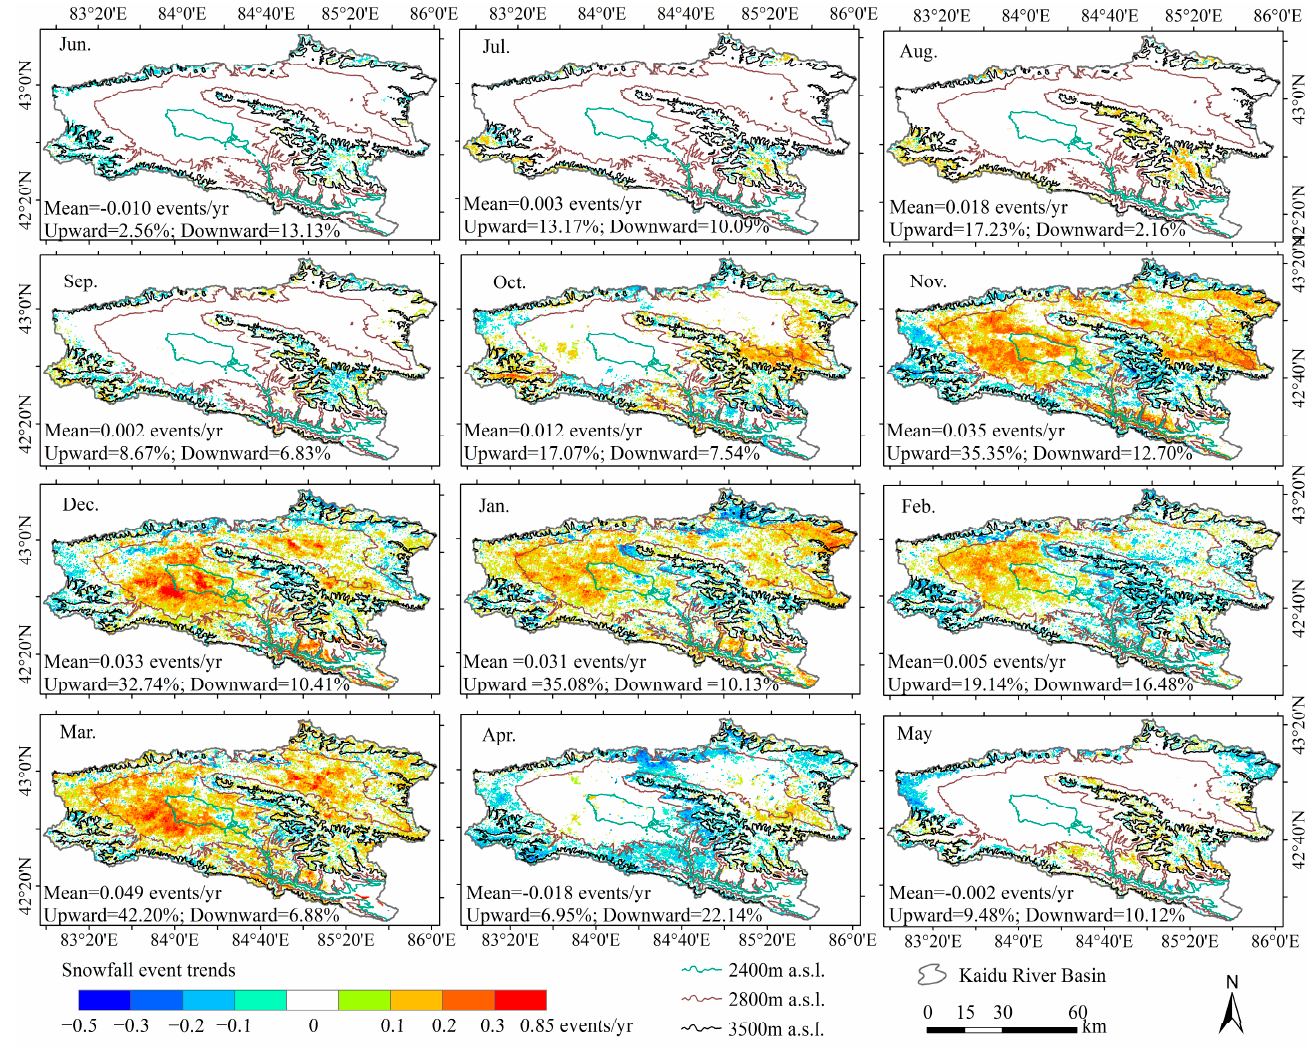
Figure 14. Spatial distributions of the trends in the monthly snowfall events over the KRB from June 2000 to May 2020. Mean = mean value of the median numbers of snowfall events.